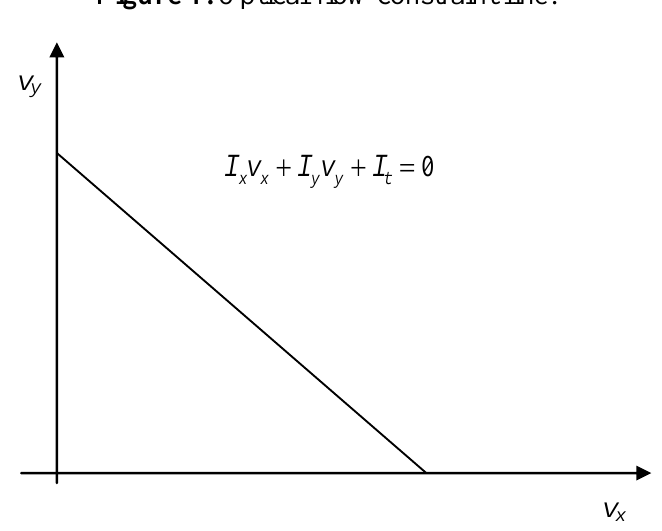
Figure 1. Optical flow constraint